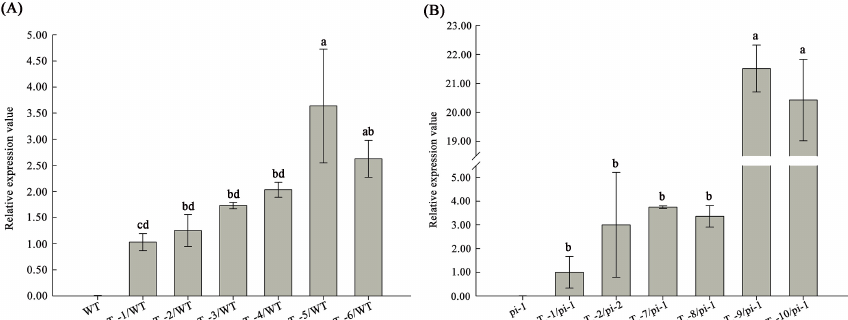
Figure 4. The CyfaPI expression was detected by RT-qPCR in the T 1 transgenic plants in wild-type and homozygous Arabidopsis pi-1 mutant background. ( A ) CyfaPI expression was detected in wild-type transgenic Arabidopsis ; ( B ) CyfaPI expression was detected in homozygous pi-1 mutant transgenic Arabidopsis . Different letters indicate statistically significant differences.